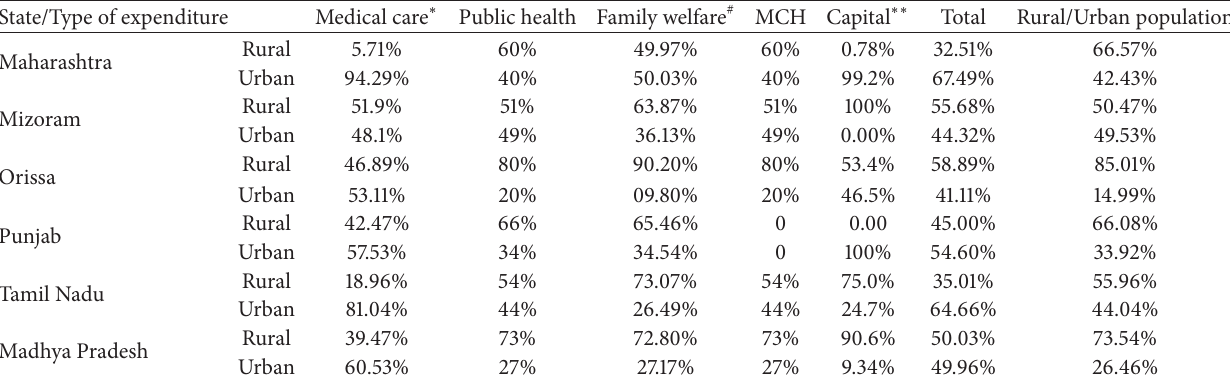
Table 12: Rural urban inequities in public health expenditure of selected states for the year 2002-03. State/Type of expenditure